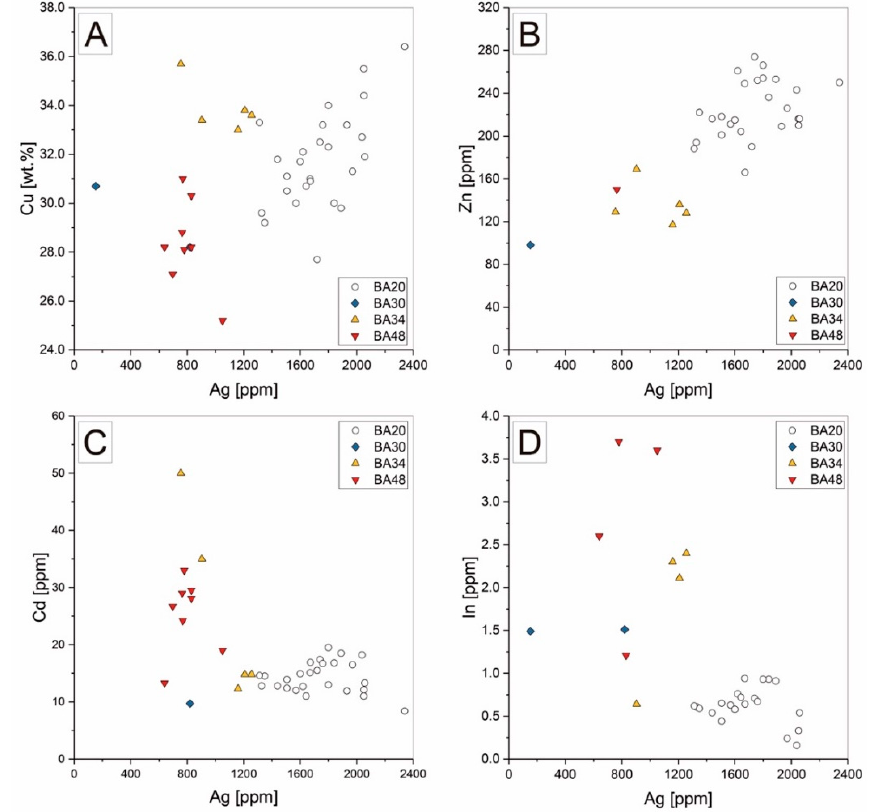
Figure 5. Bivariate plots showing Cu–Ag ( A ), Zn–Ag ( B ), Cd–Ag ( C ), and In–Ag ( D ) trends for chalcopyrite from the Cerro Pabellón geothermal system. Samples BA-20 and BA-48 are the shallowest (494 m) and the deepest (549 m), respectively, and show distinct variations in trace element concentrations. All plotted data correspond to inclusion-free LA-ICP-MS analyses (see Table S2).